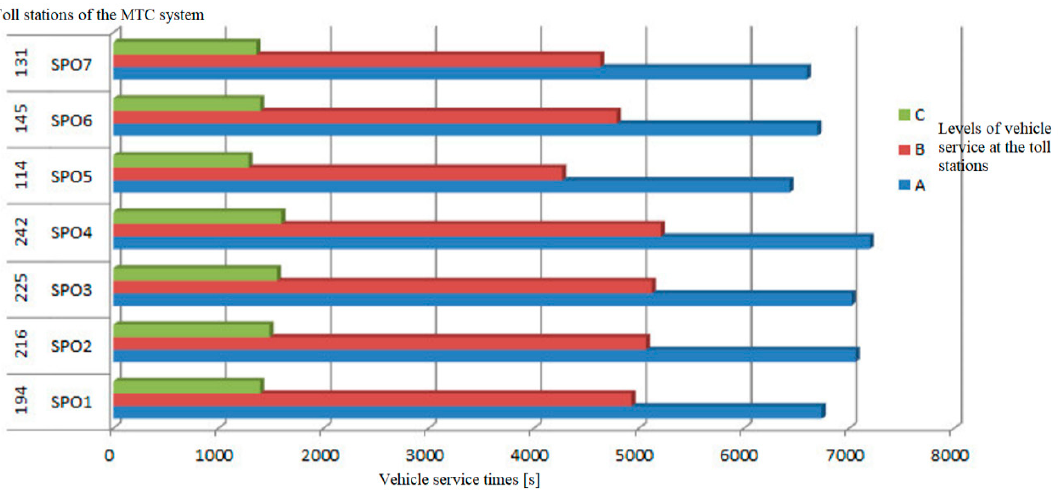
Figure 6. Distribution of vehicle service levels at individual toll stations of the MTC system. Source: own study.